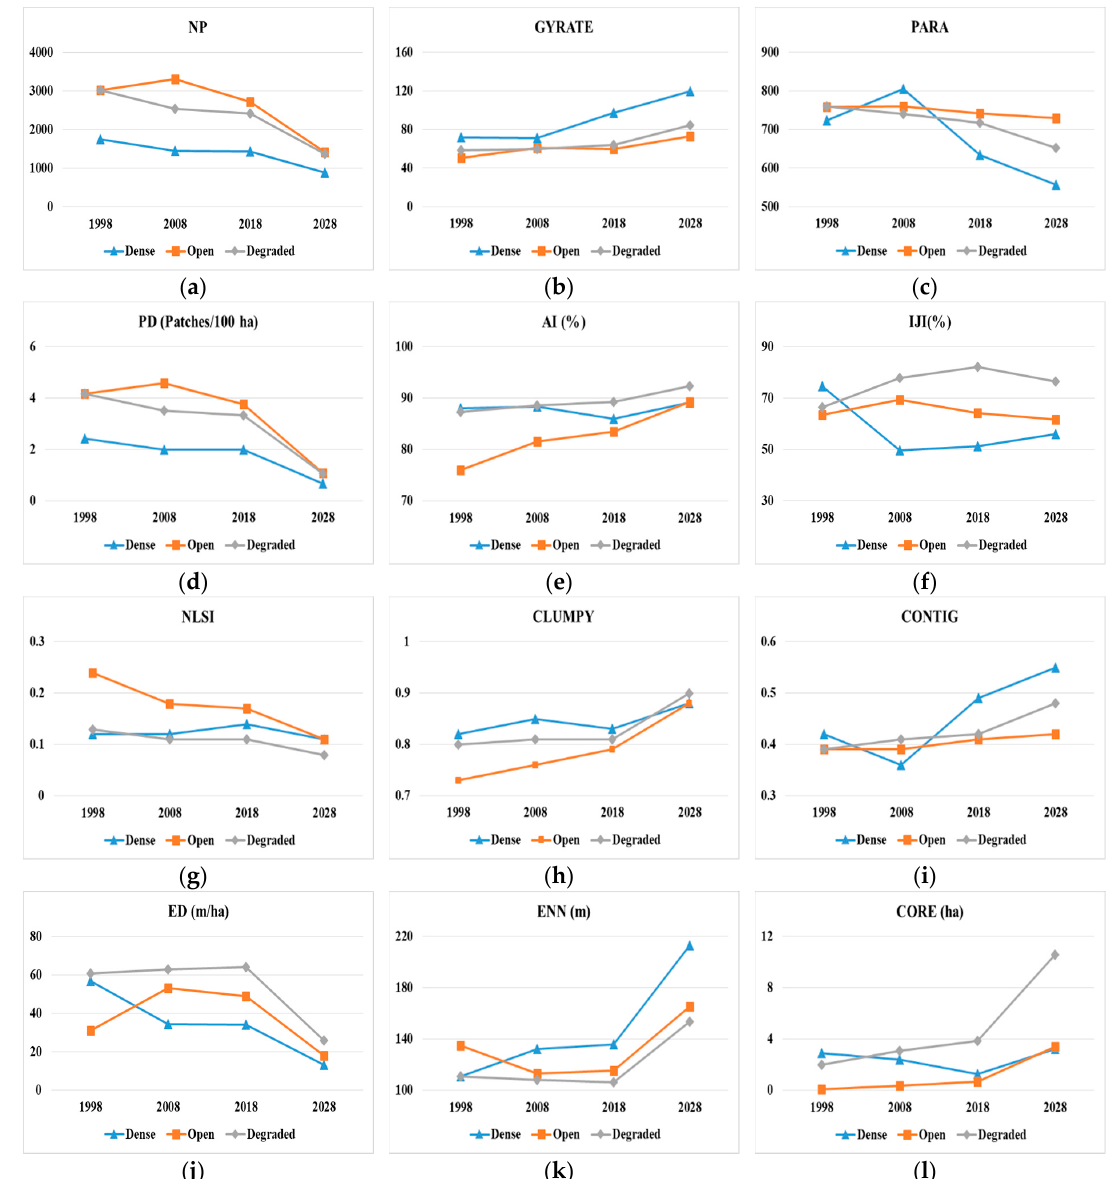
Figure 7. Different class level fragmentation metrics plotted over multi-temporal scale for different forest cover classes ( a ) Number of Patches (NP), ( b ) Radius of Gyration (GYRATE), ( c ) Perimeter Area Ratio (PARA), ( d ) Patch Density (PD), ( e ) Aggregation Index (AI), ( f ) Interspersion Juxtaposition Index (IJI), ( g ) Normalized Land Shape Index (NLSI), ( h ) Clumpiness (CLUMPY), ( i ) Contiguity Index (CONTIG), ( j ) Edge Density (ED), ( k ) Euclidean Nearest Neighbour (ENN), and ( l ) Core Area (CORE).